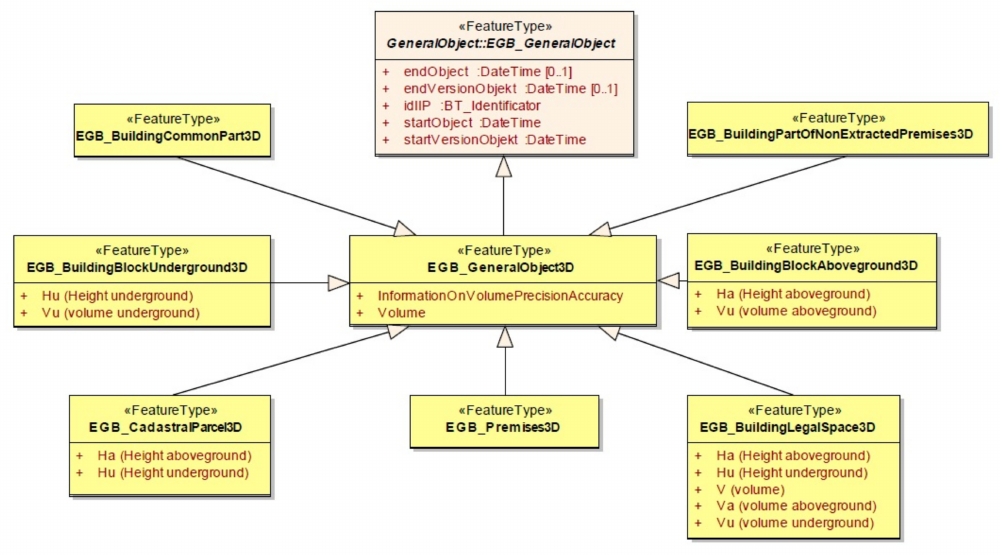
Figure 9. Diagram of ‘GeneralObject3D’ defining the generalisation relationships between ‘EGB_GeneralObject’, ‘EGB_GeneralObject3D’ and the classes created for the proposed 3D cadastre.